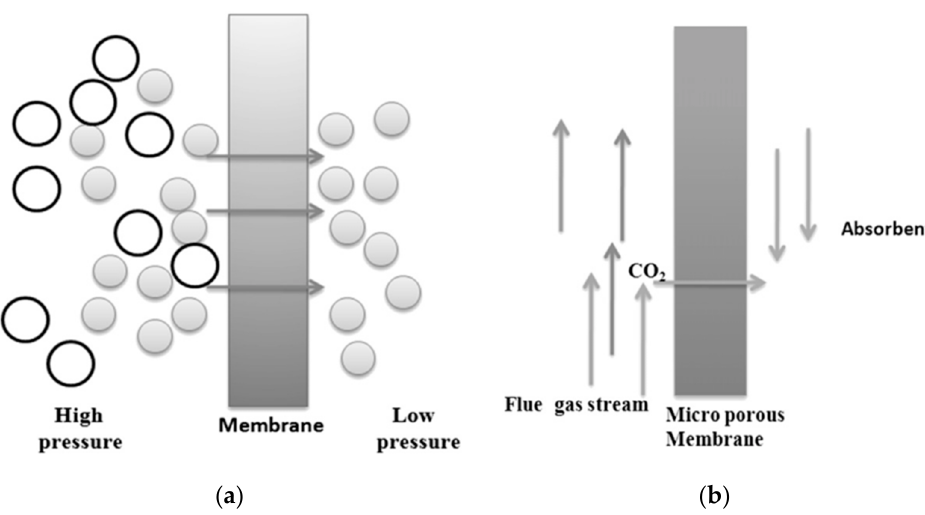
Figure 9. Principle of ( a ) gas separation membrane and ( b ) gas absorption membrane